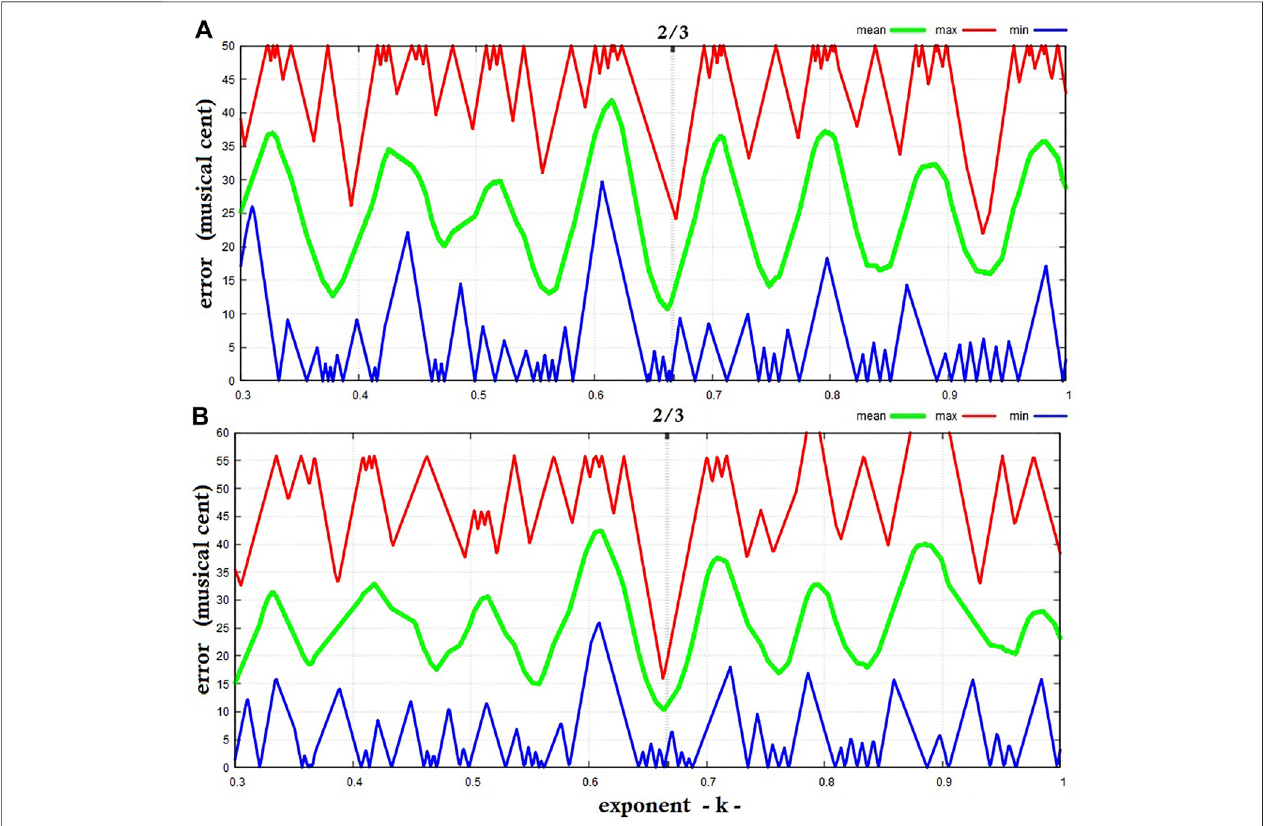
FIGURE 4 | Exponent k versus average, maximum and minimum error measured in musical cents from adjacent planet distance ratios raised to the exponent k to the closest musical tone for: (A) the equal tempered 12-TET system; (B) the justly tuned 12-TJI. The value for k (cid:1) 2/3 ≈ 0.667 is highlighted.